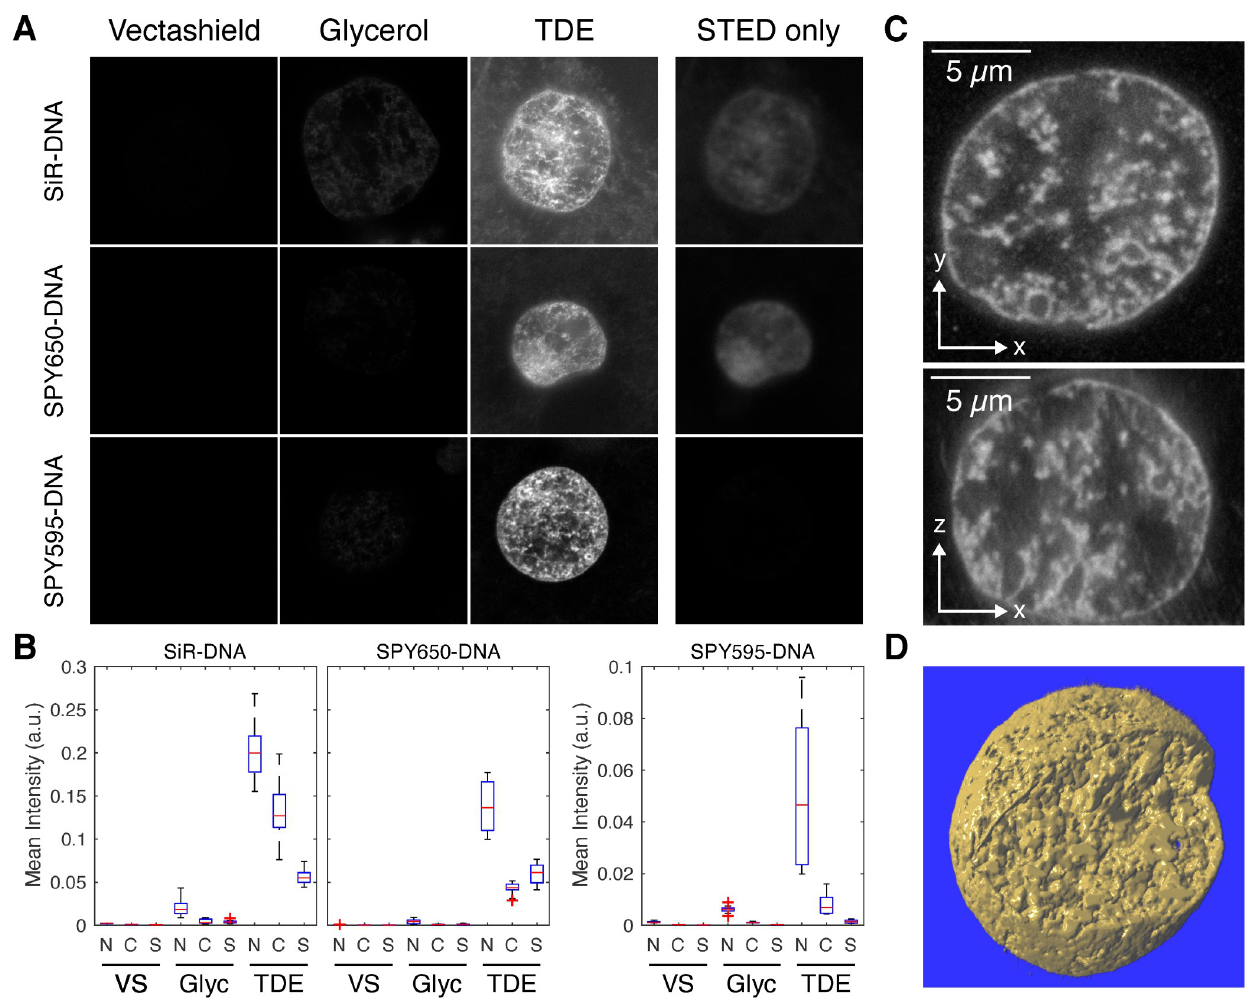
Fig 1. Improved STED DNA stains allow 3D imaging of entire nuclei and reduction of undesirable signal. A) Comparison of STED microscopy signal in an older and two improved commercially available DNA stains. All stains were applied in the mounting media Vectashield, glycerol, and thiodiethanol- based media (TDE). SiR-DNA and SPY650-DNA were excited with 652 nm light, and detected in the window from 670 to 740 nm. SPY595-DNA was excited with 599 nm light, and detected in the window from 610 to 640 nm. No gating was applied in detection. In the STED only condition, only the STED laser but no excitation laser was used on the TDE samples. Images were recorded from oblong stage embryos and show a field of view of 25 μ m by 25 μ m B) Quantification of nuclear (N), cytoplasmic (C), and STED only (S) intensity for the different stain-media combinations. Number of assessed nuclei: SiR-DNA n = 5, 10, 5; SPY650-DNA n = 6, 8, 13; SPY595-DNA n = 7, 13, 12. C) XY and XZ slices through a full 3D stack of a nucleus in a SPY595-DNA stained sphere stage embryo. D) 3D rendering of data shown in panel C, one quarter of the image stack was cut away to reveal the inside of the nucleus (Volume Viewer ImageJ plugin was